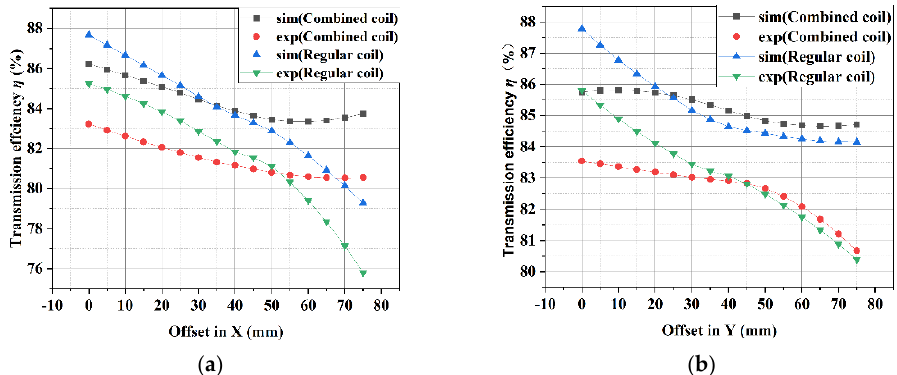
Figure 15. Variation of transmission efficiency with offset distance: ( a ) X−axis; ( b ) Y−axis. The offset rates of the transmission efficiency of different DD coils presented in other studies are compared in Table 5. The offset rate of the combined DD coil proposed in this work is reduced by 71.1% in the X direction and 44.7% in the Y direction compared to that of the regular DD coil. The double-spacing coil, however, has little change in the arrangement in the Y direction; hence, the offset rate is reduced only in the X direction. The combined structure has similar offset rates in the X and Y directions and thus shows greater promise for practical applications. Table 5. Comparison of offsets in transmission efficiency.